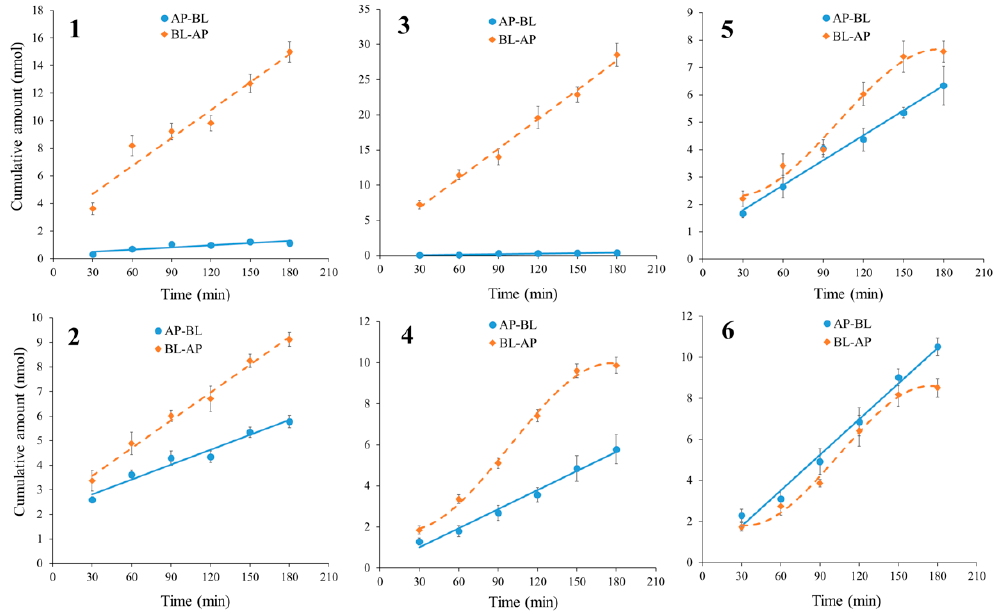
Figure 3. The bidirectional transport cumulative amounts of six alkaloids in MDCK-pHaMDR cell monolayer as a function of time from 30–180 min. Alkaloids 1 – 6 were at 40 μ M. Data are the mean ± SD ( n = 6).